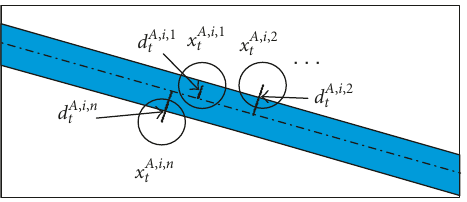
Figure 5: Calculating the camera collaboration weights for target i in view A. Circles instead of ellipses are used to represent the parti- cles for